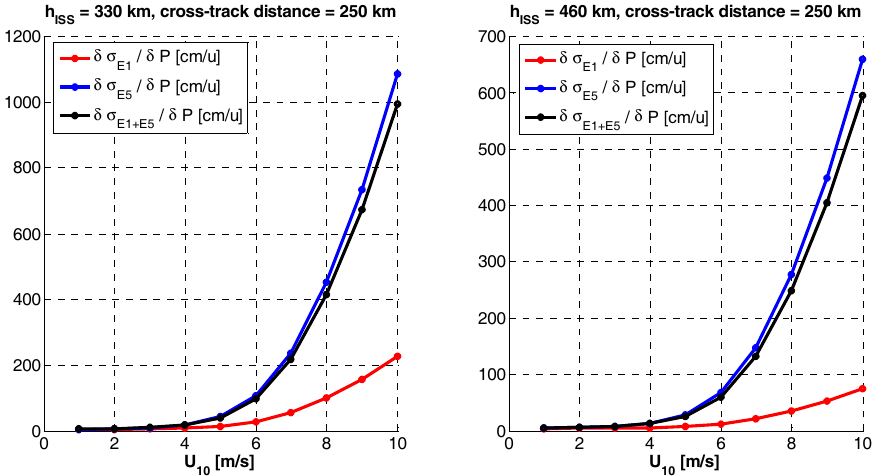
Figure 16. RMS height error sensitivity to receivers noise figure [dB]; errors (P) at nominal values (NF nom = 3.5 dB), u = [dB].